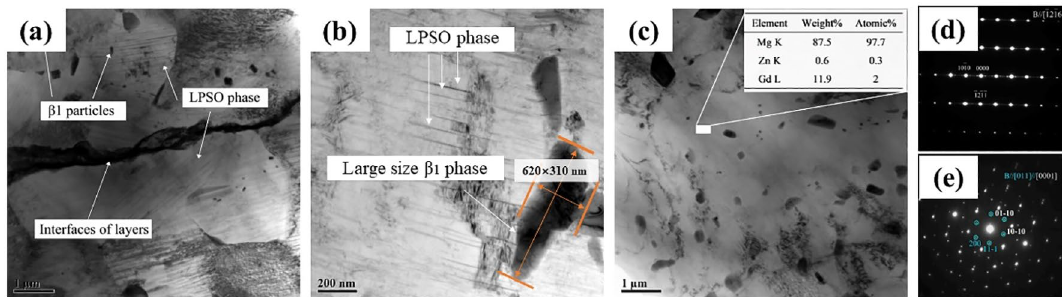
Figure 7. TEM images of SPSed Mg-15Gd-1Zn bulk under the sintering condition of 450 °C −40 MPa-5 min: ( a , b) displaying the lamellar LPSO phase formed during the sintering process; ( c) the β 1 phase particles, ( d , e) showing the selected area electron diffraction (SAED) patterns of LPSO phase and β 1 phase, respectively, the beam was parller to 12–16 and [0001] (011), the white indices were for the Mg matrix with a hcp structure, and blue indices were for β 1 phase with a fcc